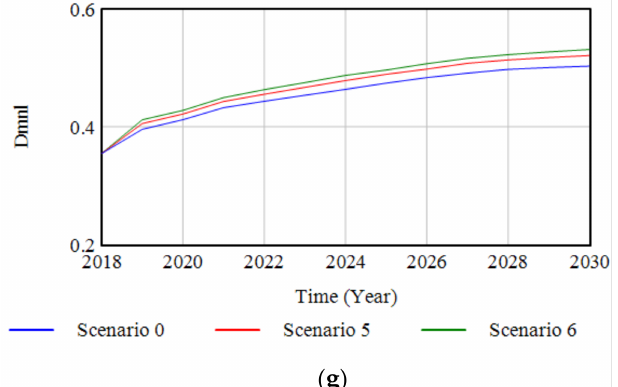
Figure 8. Variation of indicators in combined scenarios. ( a ) Annual profits; ( b ) annual costs; ( c ) emis- sion reduction per ton of clinker; ( d ) annual CO 2 emissions; ( e ) annual carbon trading costs; ( f ) inno- vation investment; ( g ) competitiveness index of the cement company.